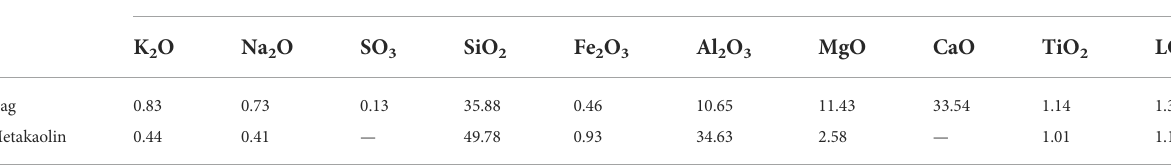
TABLE 1 Chemical compositions of metakaolin and slag.